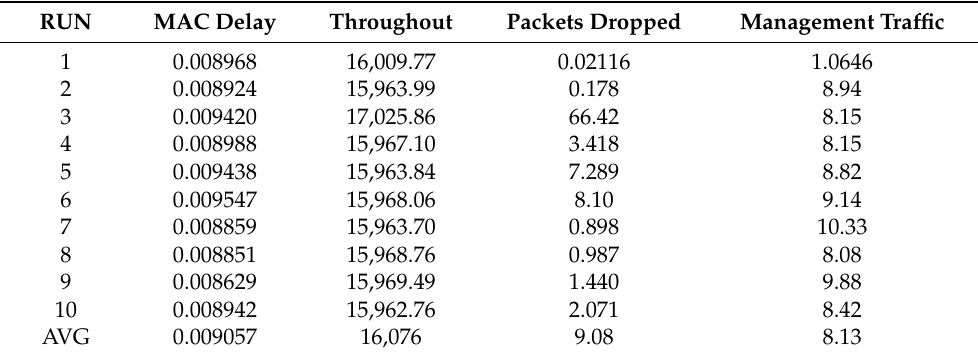
Table 1. Simple Scenario ZigBee Standard.